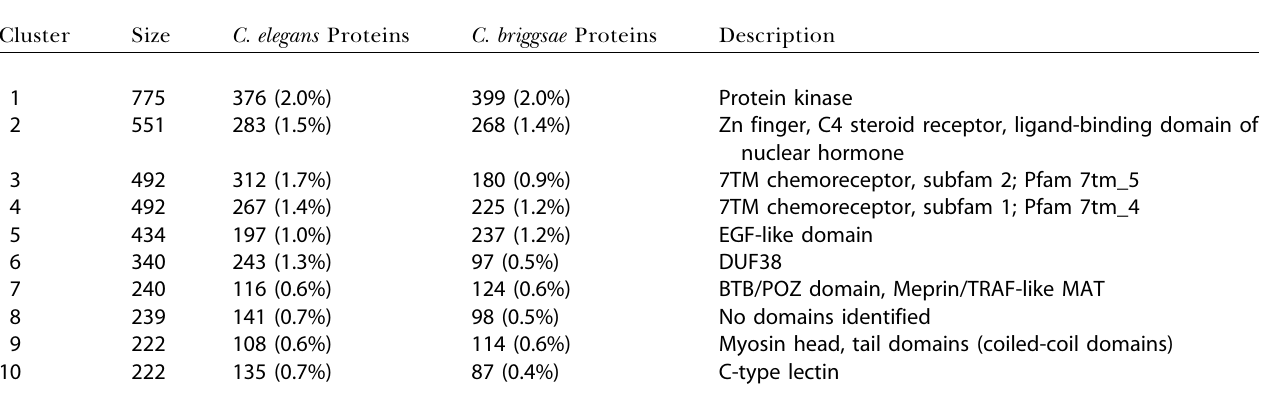
Table 3. Top Ten Protein Clusters by Size in C. elegans and C. briggsae Cluster Size